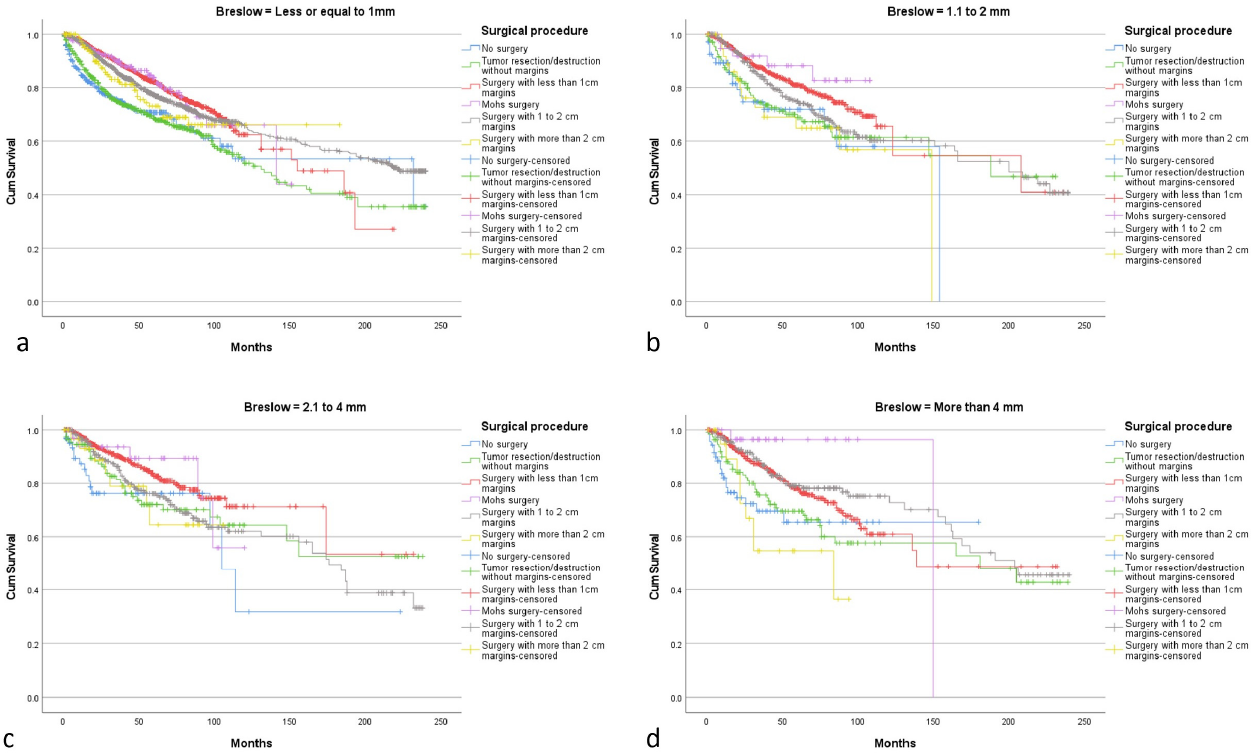
Figure 4. ( a – d ) Overall survival curves according to surgical procedure, stratified by Breslow thickness. In multivariable analysis, increasing age, male gender, nodular histologic subtype, regional and distant disease, the use of radiotherapy, the use of chemotherapy, increasing mitotic rate and the presence of an ulceration on the primary tumour were identified as independent prognostic factors of decreased OS. (Table 3) Breslow thickness and type of surgical resection did not affect OS in multivariable